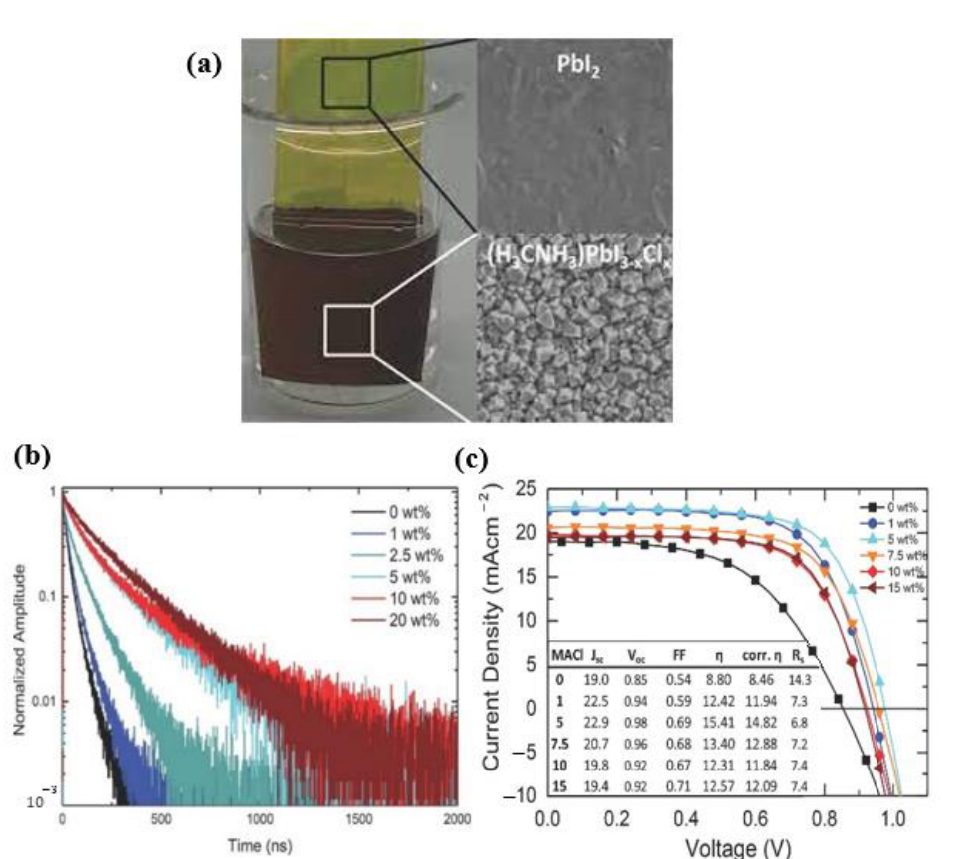
Figure 6. ( a ) Dip–coating solution preparation method for the perovskite films and the corresponding surface morphologies in PbI 2 , MAPbI 3-x Cl x , and/or MAPbI 3 thin films. ( b ) Time-resolved photoluminescence spectrum and ( c ) photovoltaic performance in planar heterojunction solar cells of MAPbI 3 and MAPbI 3-x Cl x at various wt% addition of MACl [20].